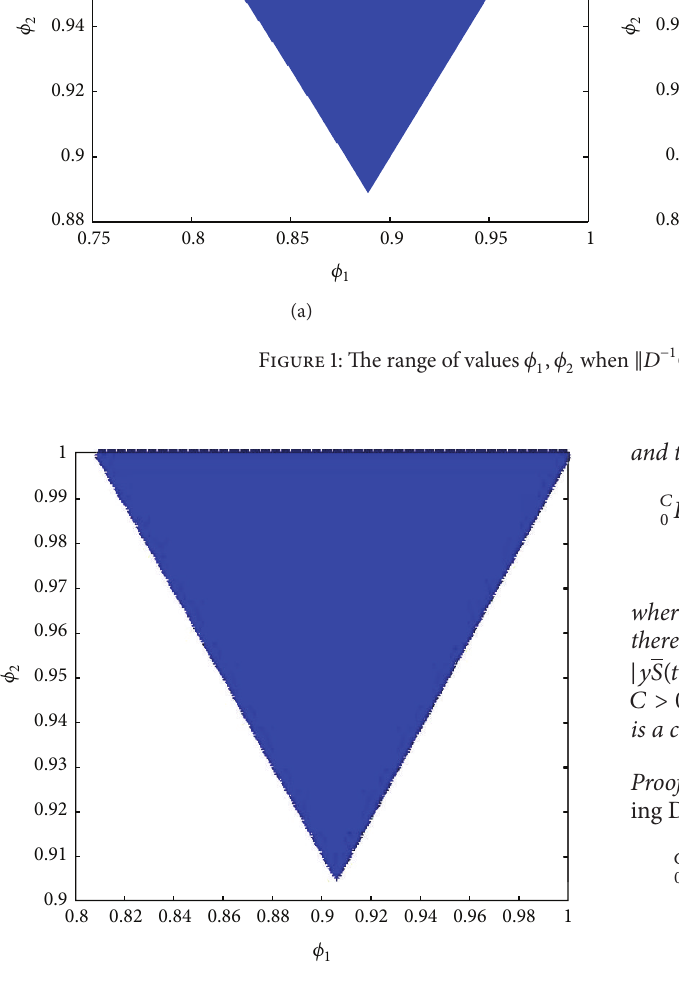
Figure 2: The range of values 𝜙 1 , 𝜙 2 when ‖ 𝐷 −1 𝐶‖ ∞ < 1